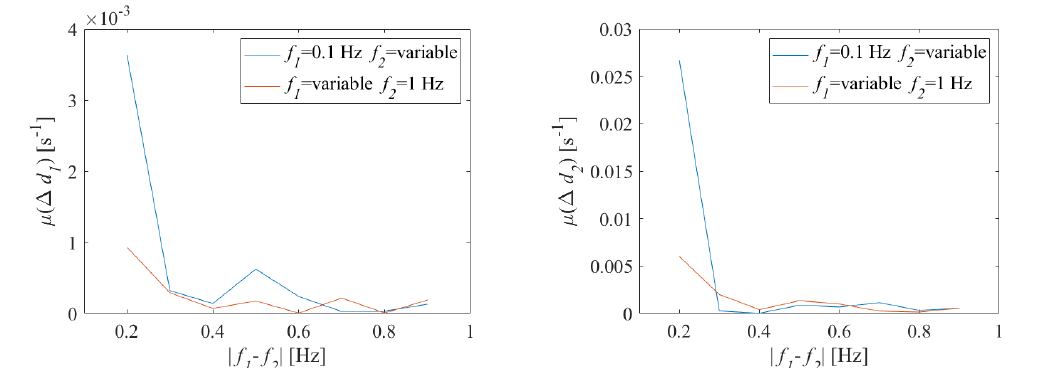
Figure 11. Mean of ∆ d versus the frequency distance between the components obtained in numerical tests with noise and quantization; results for components with damping d 1 ( on the left ) and damping d 2 ( on the right ).